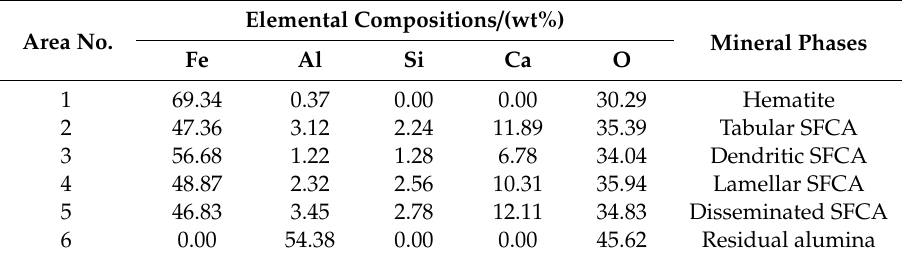
Figure 12. E ff ect of diaspore on the characteristics of the bonding matrix (P: Pore; a → b: Rotate 90 ◦ to the right; ( a , b ) are the optical and SEM photographs of the reaction interface respectively; ( c ) is the photograph of line scan in ( b )). Table 7. EDS analysis results for areas in Figure